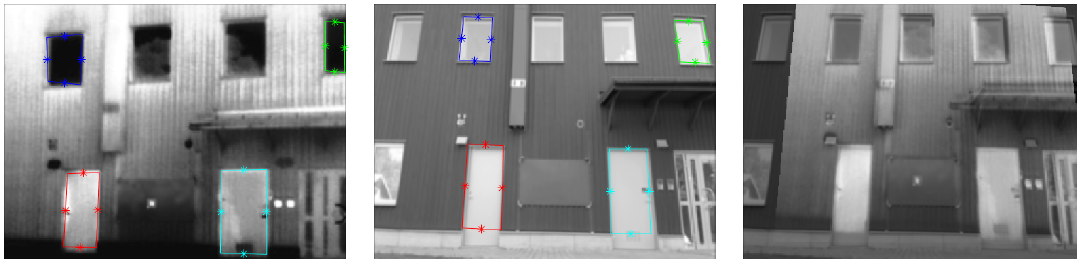
Figure 2. Quadrilateral features derived from horizontal and vertical line segments are used for registering infrared (IR) and visible image pairs in this study. The edge center points of each quadrilateral (indicated by asterisks) serve as control points to establish correspondences (encoded by the same colors) and to calculate the underlying geometric transformation. Left: IR image. Middle: visible image. Right: composited image after